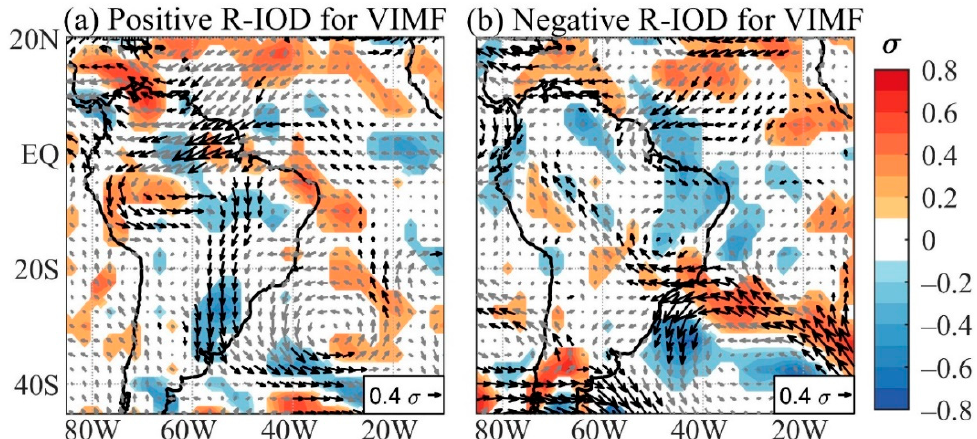
Figure 12. Composites of the anomalies of the residual VIMF components and of their divergence (shades) during austral spring for the: ( a ) positive R-IOD; and ( b ) negative R-IOD. In this Figure, residual means without the TPO effects. Graphical display is the same as that in Figure 7.